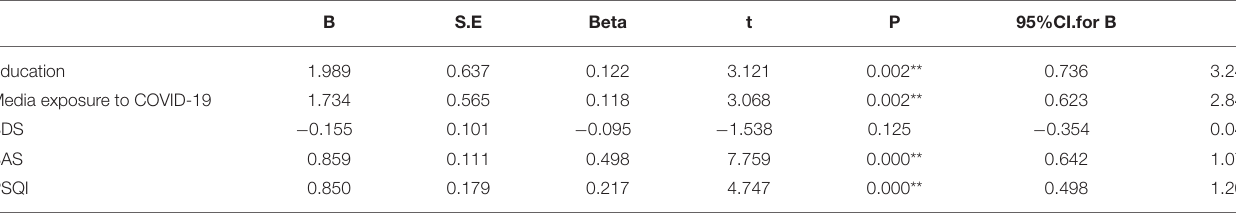
TABLE 4 | Multiple regression results of IES-R total score and related variables among depressed group.